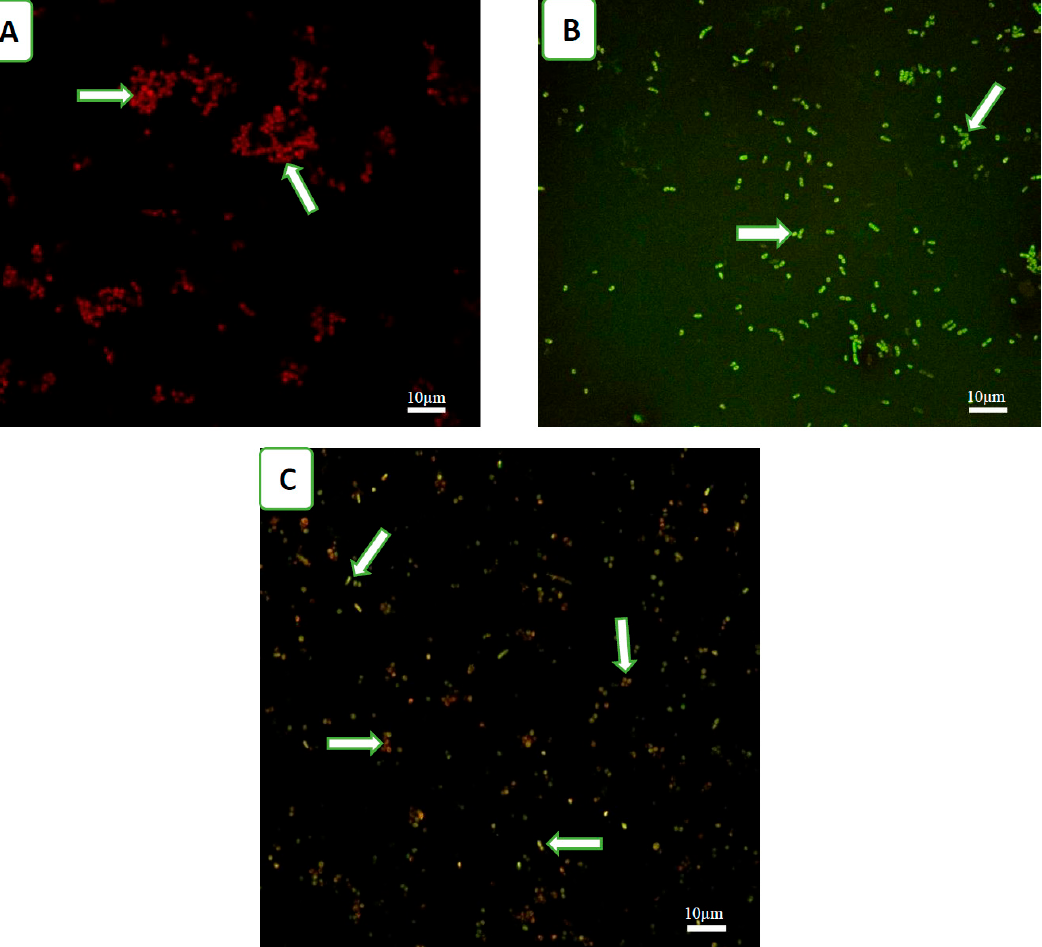
Figure 1. Fluorescence strain under confocal microscopy: ( A ) mCherry-labelled S. aureus KUB7, ( B ) GFP-labelled P. aeruginosa PAO1, and ( C ) mCherry-labelled S. aureus KUB7 mixed with GFP-labelled P. aeruginosa PAO1.